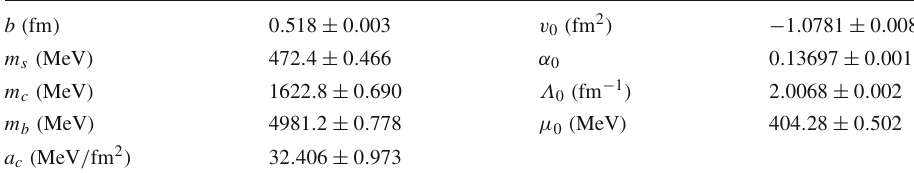
Table 1 Model parameters. The mass of the u / d quark is fixed to m u / d = 313 MeV